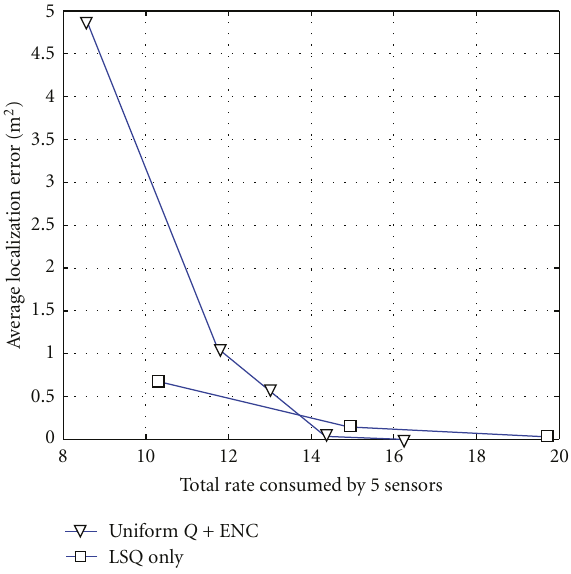
Figure 10: Performance comparison: Uniform quantizer equipped with distributed encoding algorithm versus LSQ only. Average localization error and total rate, R M are averaged for 100 di ff erent 5-node